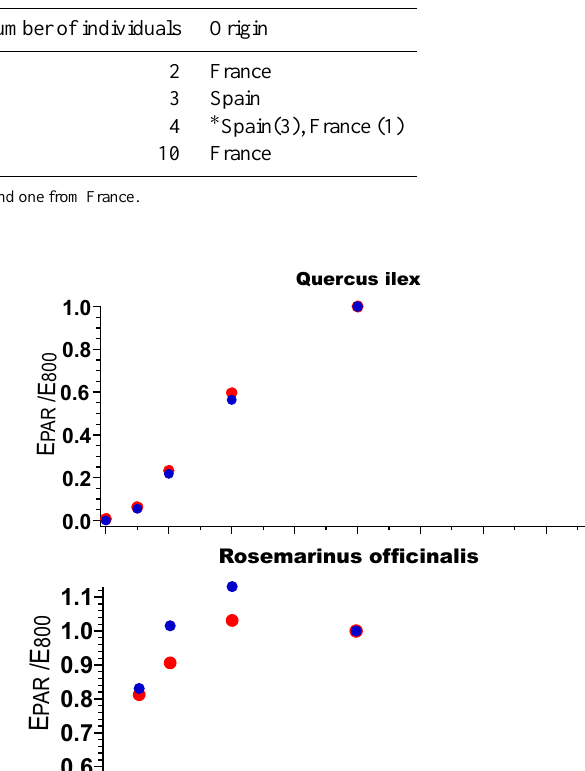
Table 2. Chemotypes of the screened individuals.